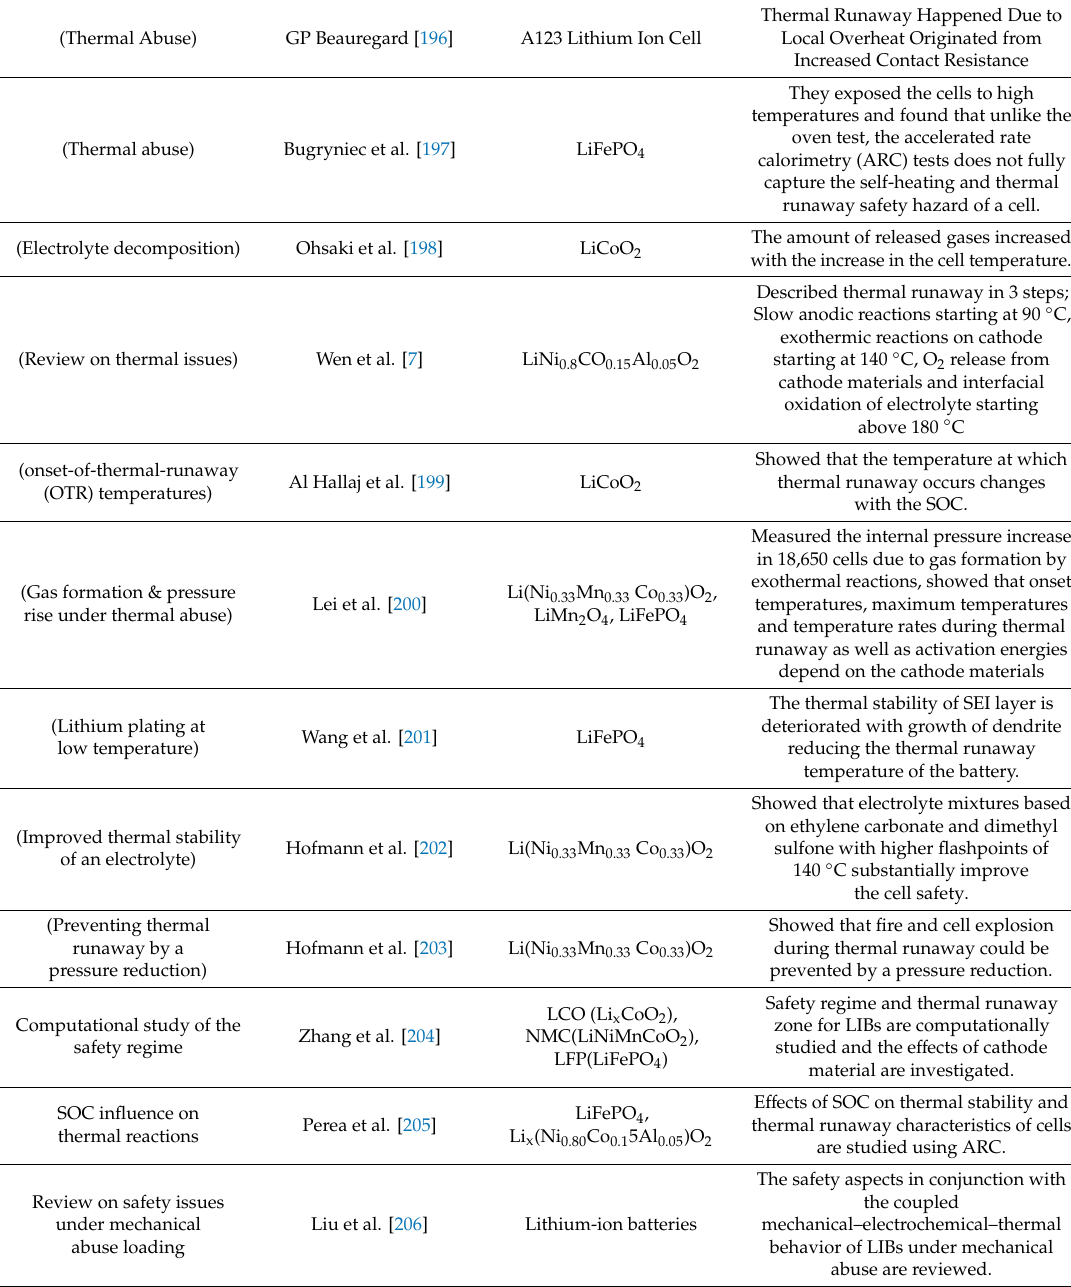
Table 2. Review of thermal e ff ects on LIB’s